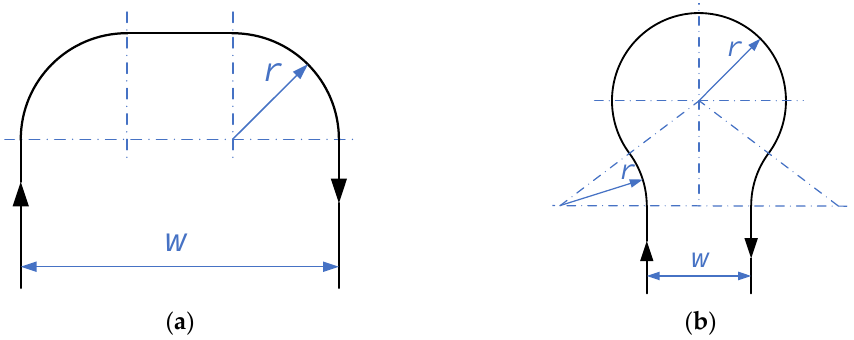
Figure 2. Turning strategy with parallel working paths. ( a ) U-turn; ( b ) Ω-turn. When two working paths intersect, the tractor is steered less than 180° at the inter- section near the two working paths at the head of the field. According to the angle of the two intersecting working paths, there are two types of turning shown in Figure 3: the acute angle and the obtuse angle. The algorithm for generating the two turning paths is the same, which translates the distance r from the intersection of the two working paths to the inside of the angle. The intersection point of the translated working paths is taken as the center of the circle, and the distance r is taken as the radius to make an arc, which is the desired turning path tangent to the two working paths.